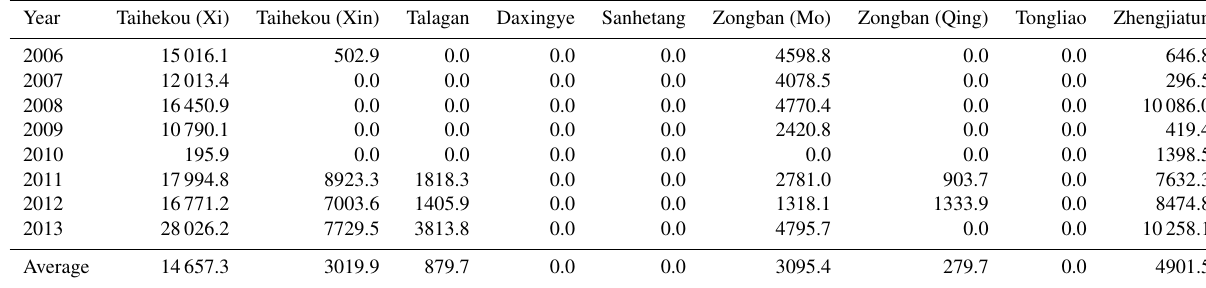
Figure 1. Hydrological station distribution schematic in West Liaohe River Plain. Table 1. The statistical results about runoff of each hydrological station in the West Liaohe River Plain.